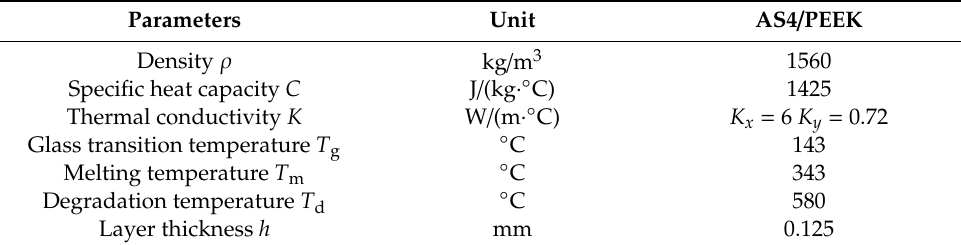
Table 2. Mold attributes (45#